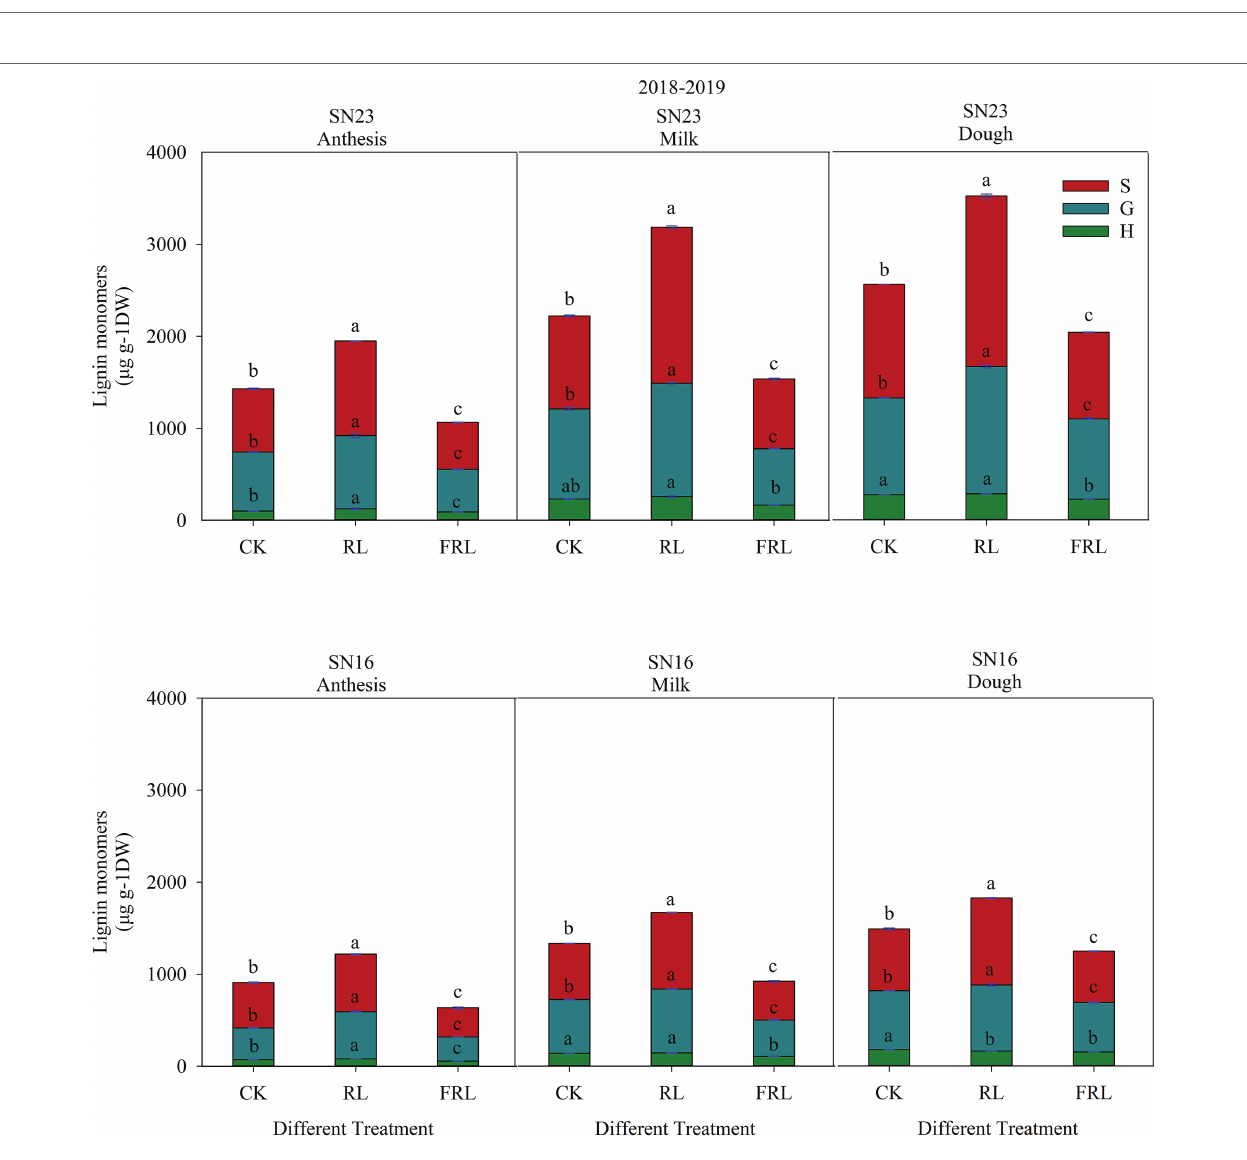
FIGURE 5 | The effect of light quality in population on lignin subunit content in wheat in 2018–2019 growing seasons. SN16 and SN23 represent the lodging- sensitive cultivar Shangnong16 and the lodging-resistant cultivar Shangnong23. CK represents the normal light, RL represents the red light, and FRL represents far-red light. H, G, and S represent p-hydroxyphenyl lignin, guajacyl lignin, and syringyl lignin, respectively. Vertical bars above mean values indicate SDs ( n = 3). Means show significant differences between treatments according to the LSD ( p <